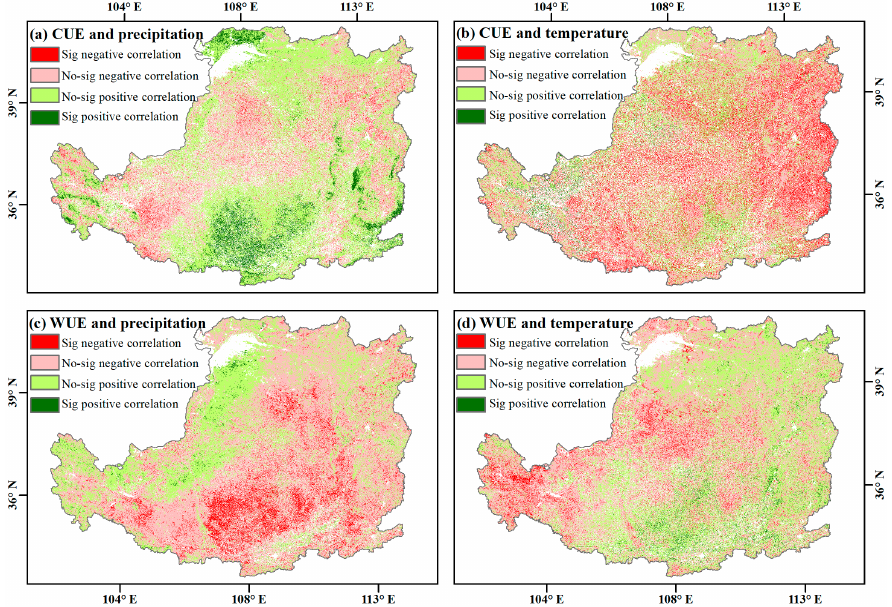
Figure 7. Significant correlations of CUE and WUE with precipitation ( a , b ) and temperature ( c , d ) in the Loess Plateau from 2000 to 2020.